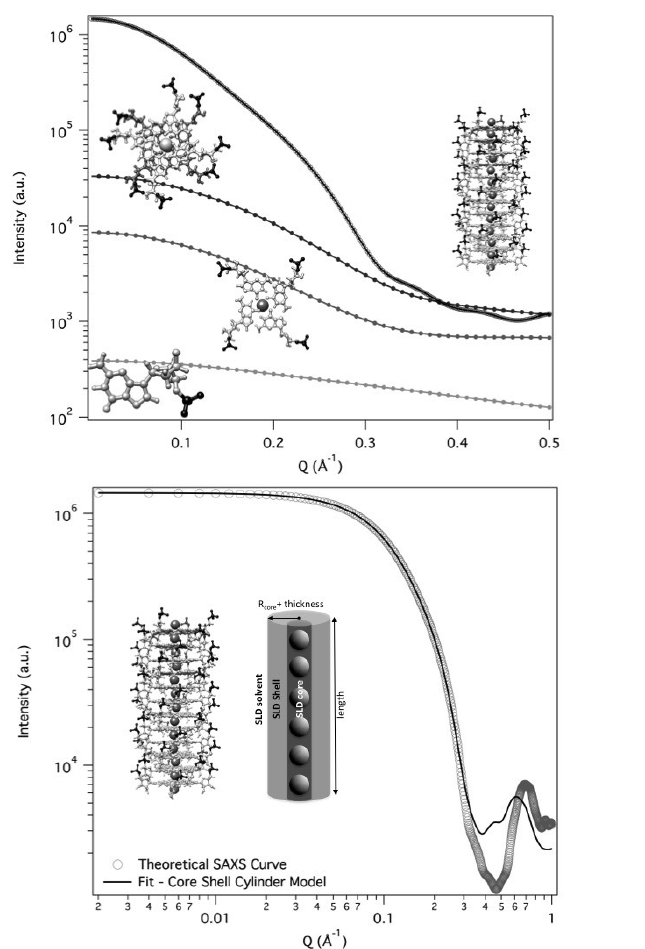
Figure 8. Top frame: theoretical SAXS curves for GMP, G-quartet, G-octamer and a dodecameric G-quadruplex obtained by GENFIT from atomic models. Lower frame: best fit of the theoretical dodecameric G-quadruplex SAXS curve (open circles) with a core-shell cylinder model (continuous line). Note that the fitting fails just at Q values higher than 0.4 Å − 1 , where the ratio between signal and noise of an in-solution SAXS curve is usually low. Fitting parameters were: R core = 2.0 ± 0.3 Å, δ = 11.4 ± 0.4 Å, L = 41.9 ± 0.5 Å, ρ core = ( 0.56 ± 0.02 ) e/Å 3 , ρ shell = ( 0.47 ± 0.01 ) e/Å 3